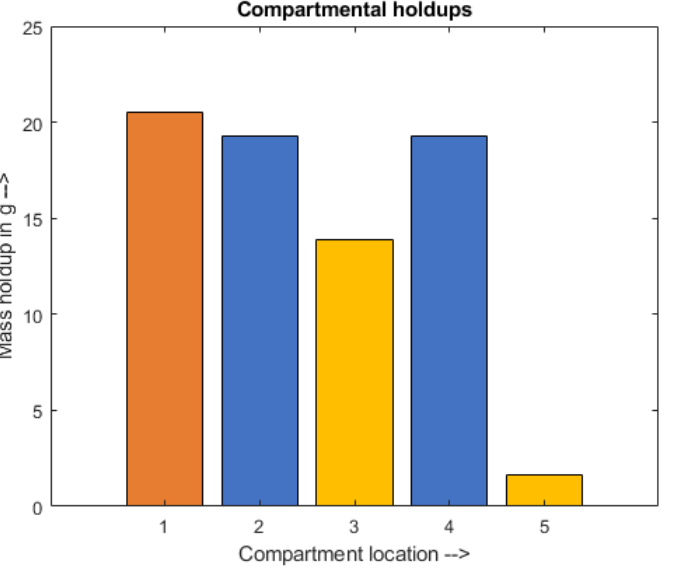
Figure 12. Compartmental holdup obtained obtained from the PBE model when trained on the system as used by Kumar et al., 2016 dataset